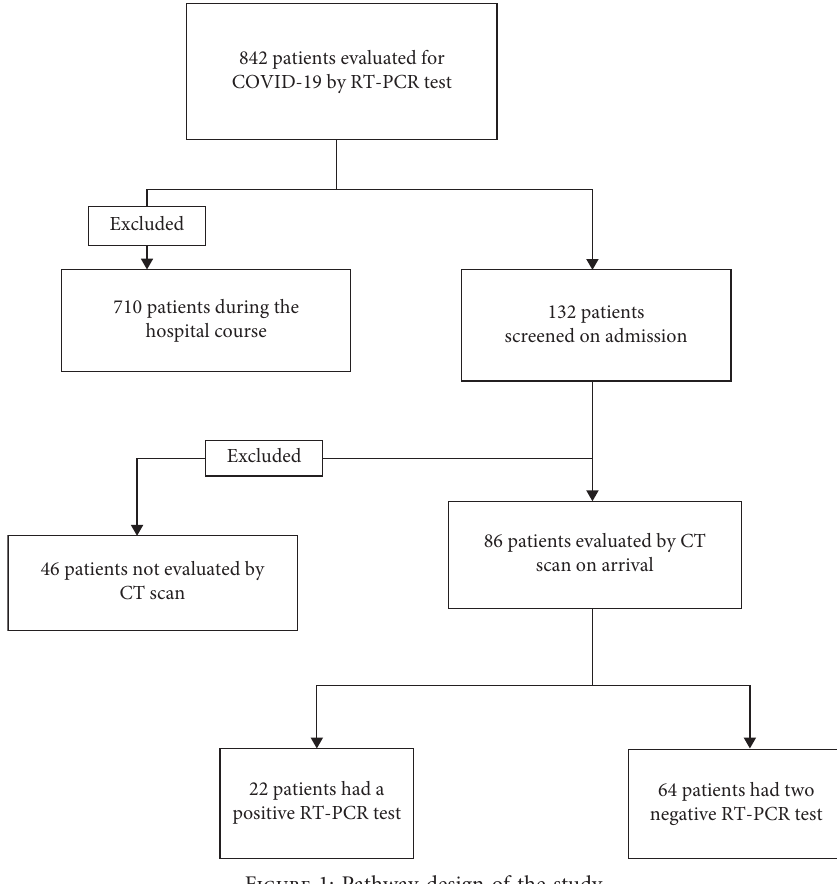
Figure 1: Pathway design of the